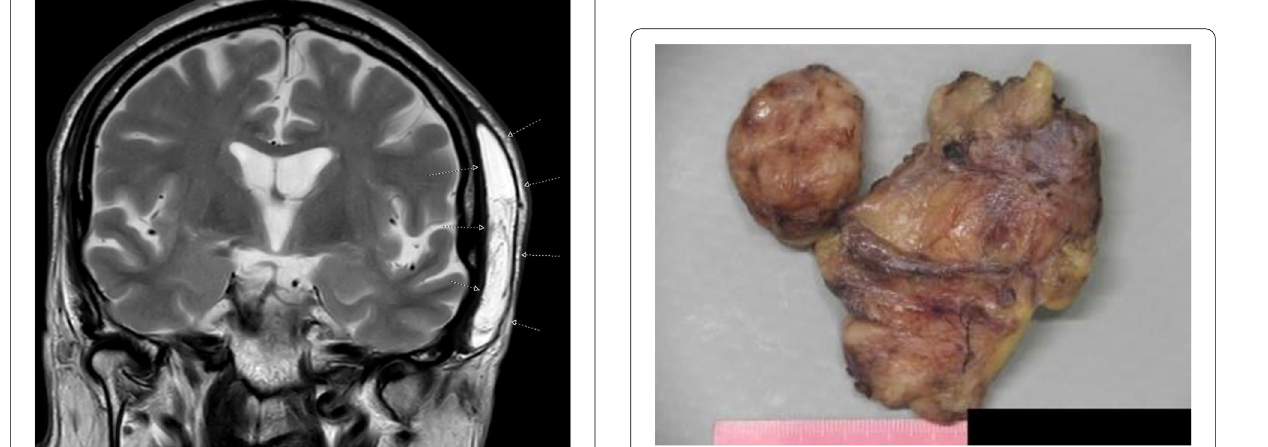
Fig. 1 Coronal T2-weighted MRI image shows prominent low signal foci in the mass lesion